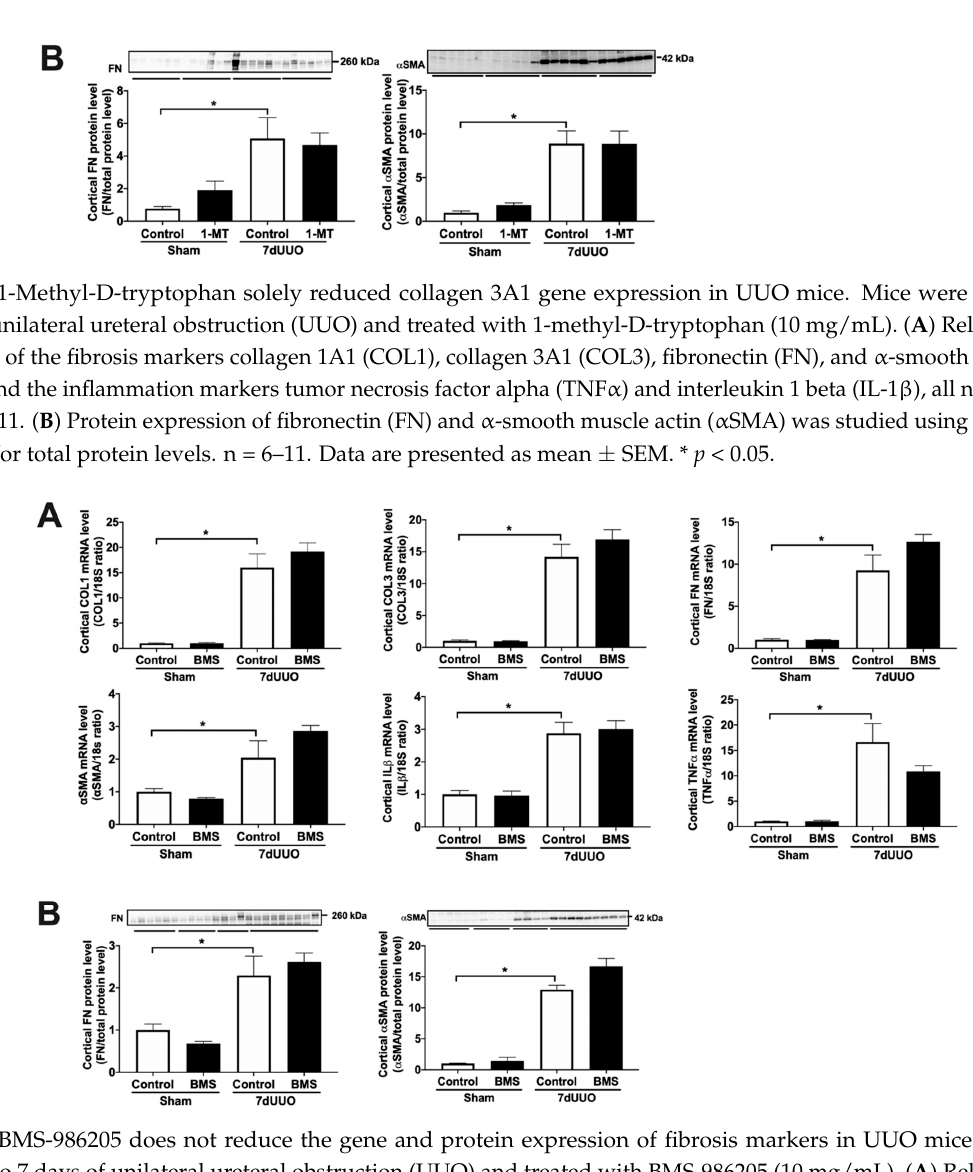
Figure 5. BMS-986205 does not reduce the gene and protein expression of fibrosis markers in UUO mice. Mice were subjected to 7 days of unilateral ureteral obstruction (UUO) and treated with BMS-986205 (10 mg/mL). ( A ) Relative mRNA expression of the fibrosis markers collagen 1A1 (COL1), collagen 3A1 (COL3), fibronectin (FN), and α -smooth muscle actin ( α SMA), and the inflammation markers tumor necrosis factor alpha (TNF α ) and interleukin 1 beta (IL-1 β ), all normalized to 18S. n = 4–7. ( B ) Protein expression of fibronectin (FN) and α -smooth muscle actin ( α SMA) was studied using western blot, corrected for total protein levels. n = 4–9. Data are presented as mean ± SEM. * p < 0.05.